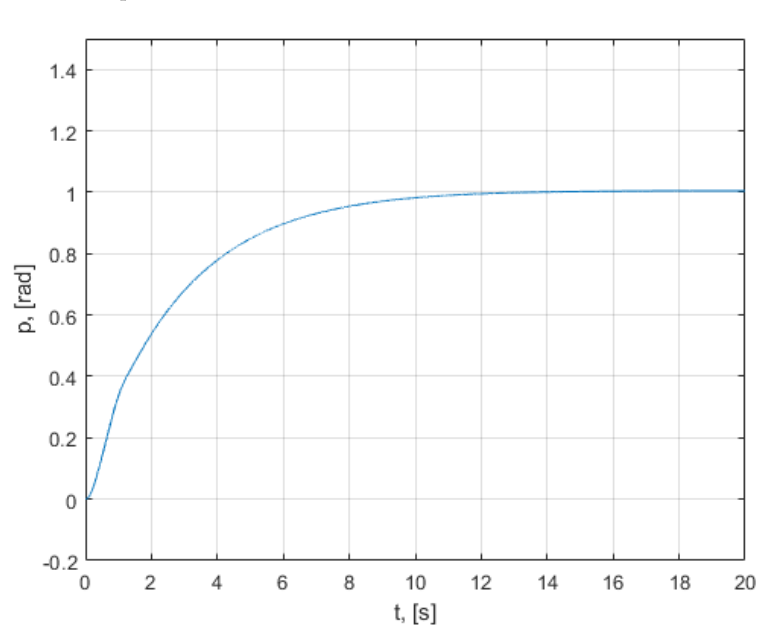
Figure 20. Speed.